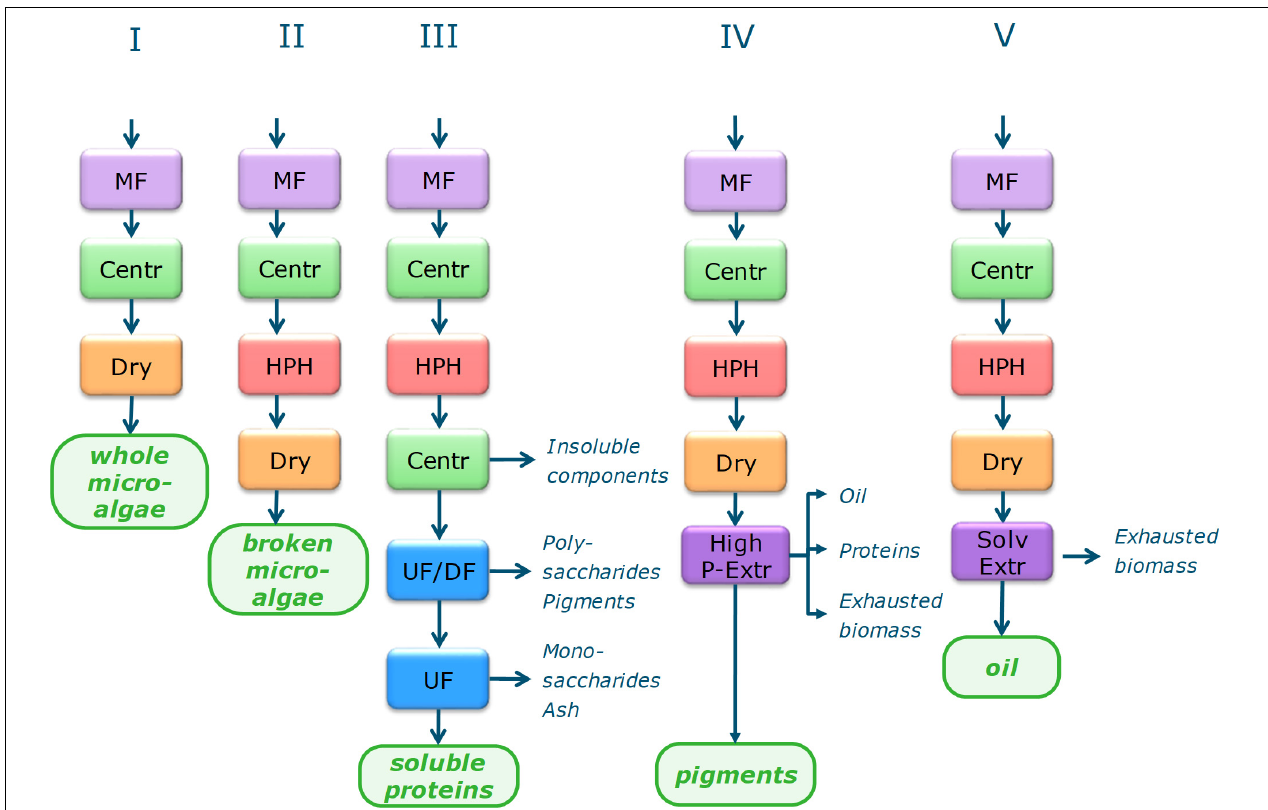
FIGURE 1 | Biorefinery process schemes for single product value chains. MF, microfiltration; Centr, centrifugation; Dry, Spray drying; HPH, high pressure homogenization; UF, ultrafiltration; UF/DF, ultrafiltration/diafltration; High P–Extr, high pressure extraction (PLE, pressurized liquid extraction; GXL, gas expanded liquid extraction; SFE, supercritical fluid extraction), Alkal Extr, alkaline extraction; Enz Hydr, enzymatic